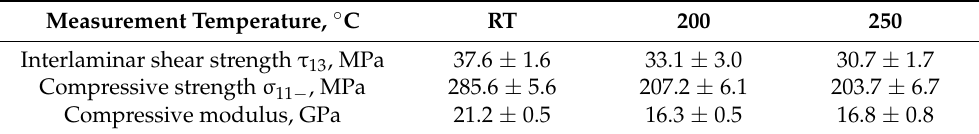
Table 4. Mechanical properties of quasi-isotropic FRP with T10 and NOV as a matrix. Measurement Temperature, ◦ C